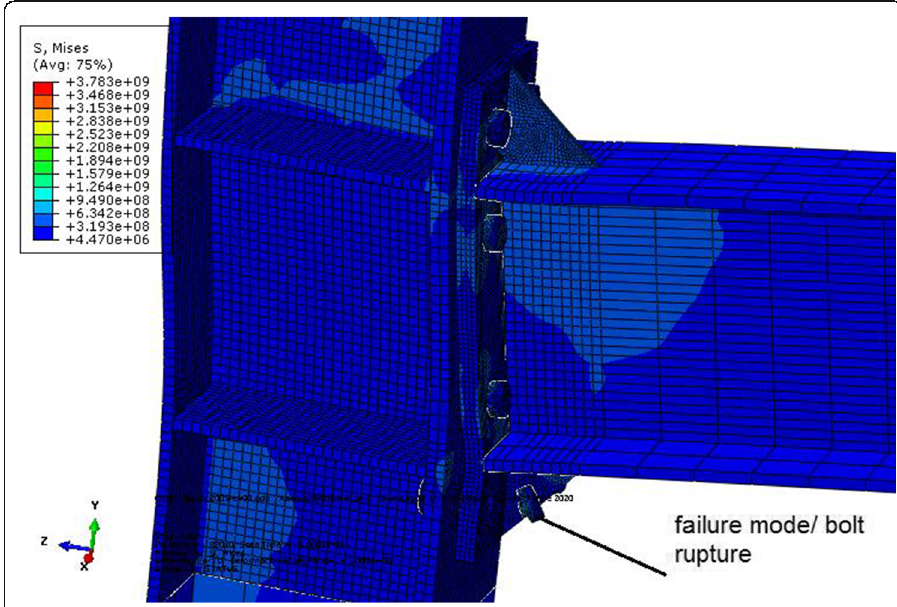
Fig. 24 Connection failure, failure of the most bottom four bolts, duration (td = 0.005) as an example of failure in connection